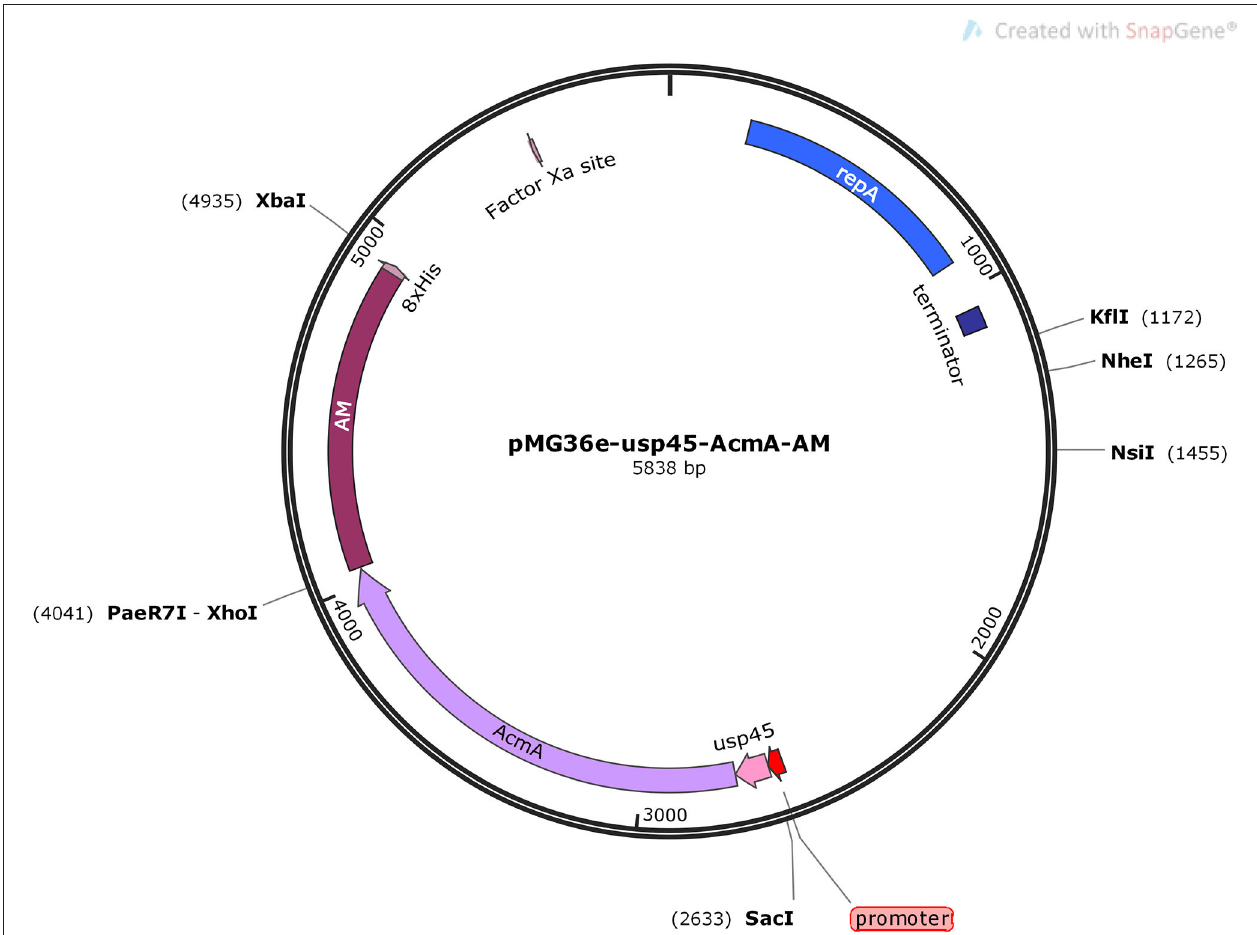
FIGURE 1 | Schematic view of building the pMG36e-usp45-AcmA-AM